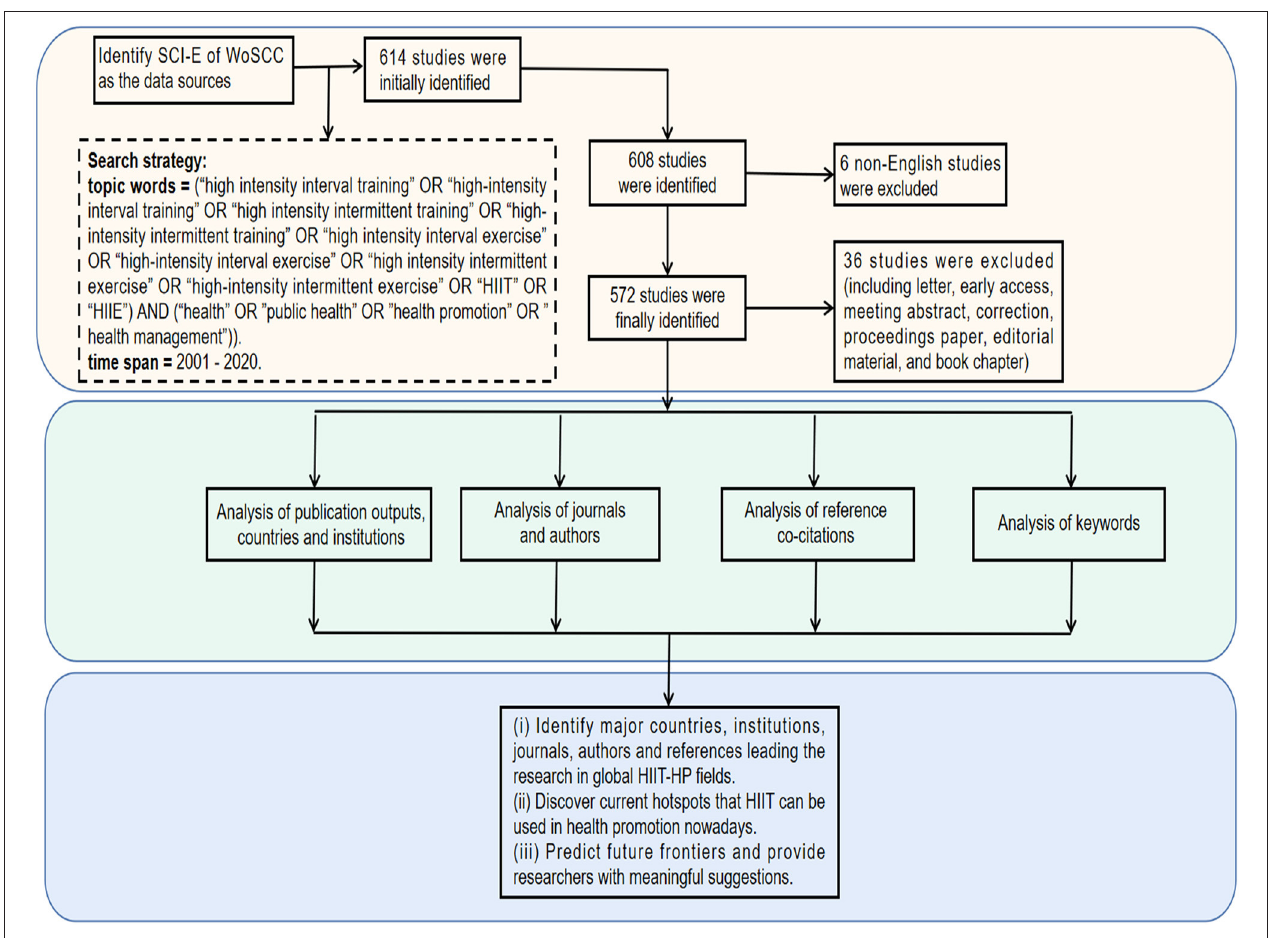
FIGURE 1 | The summary of the flowchart and study